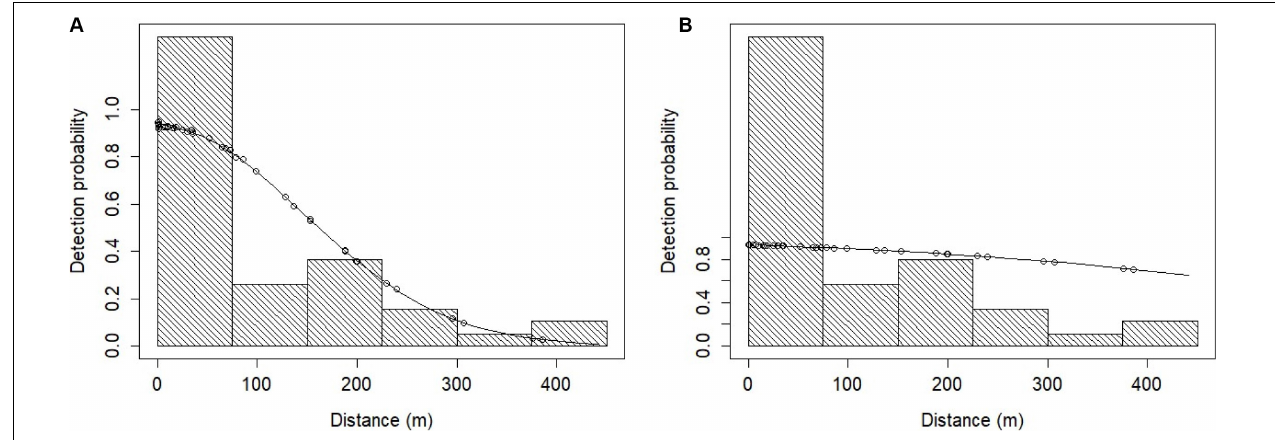
FIGURE 6 | Fitted MRDS and MR models for the dusky dolphin data under: (A) the point independence (PI) assumption, and (B) the full independence (FI) assumption. The solid line represents the fitted model and the dots represent the detection probabilities for individual primary platform detections. The histogram bars represent the perpendicular distances (m) of dusky dolphin detections truncated to 450 m. The probability of detection is above 1.0 at perpendicular distances 0 – 50